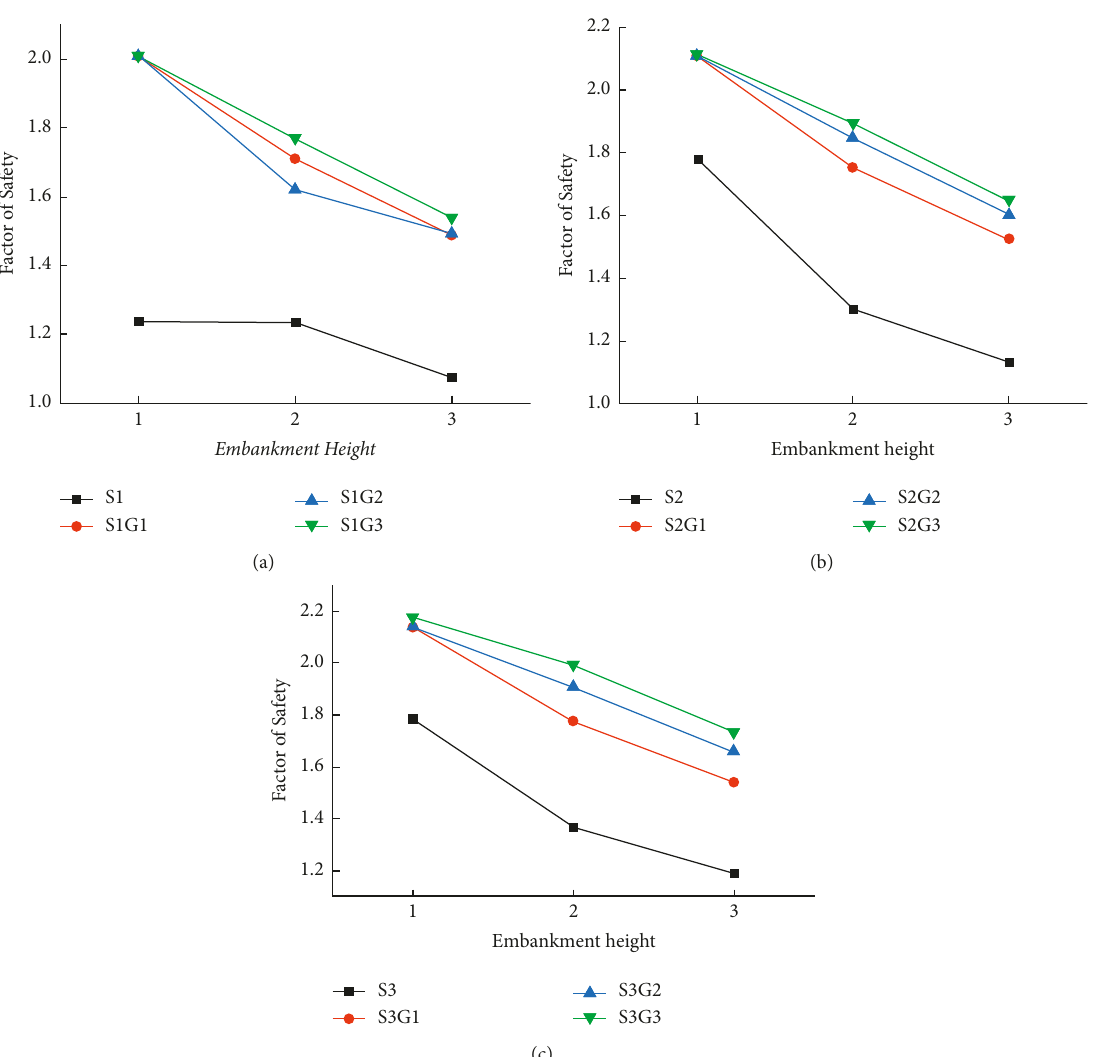
Figure 4: The effect of slopes on a factor of safety of the embankment (a) for S1 (b) for S2 and (c) for